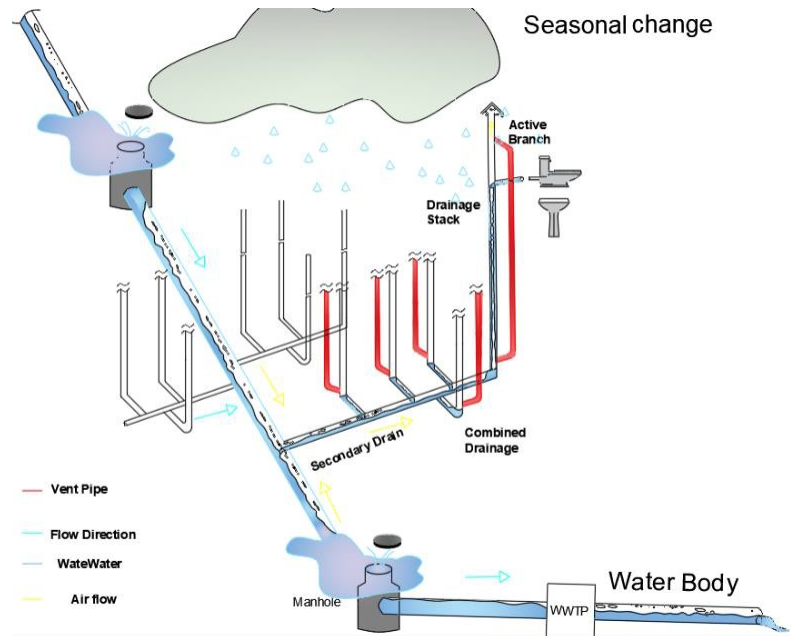
Figure 5. Storm, tall buildings, and wastewater collection system pipeline .